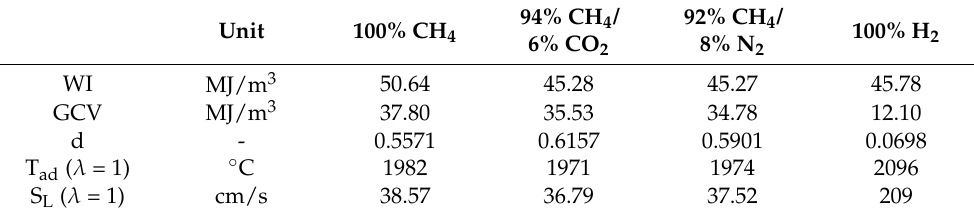
Table 1. Fuel properties of CH 4 , two CH 4 /inert blends and 100% H 2 1